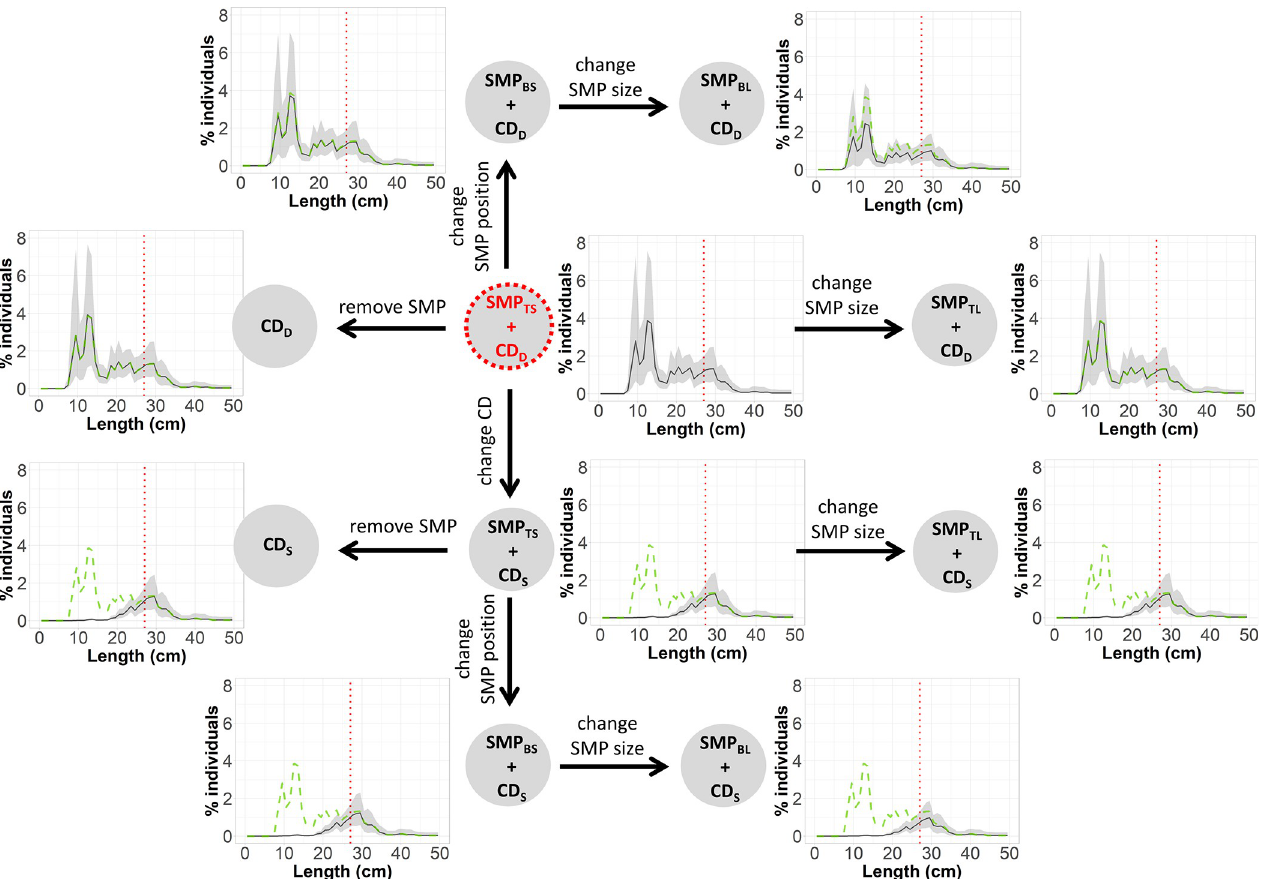
Fig 9. Treatment tree of the population structure fished for hake with the different gear designs. Includes the fished population structure (black line) for each gear design and CIs (grey bands) and the population structure fished by the reference gear design (SMP TS + CD D ) (green dashed lines). Vertical red dotted lines correspond to the MCRS: 27